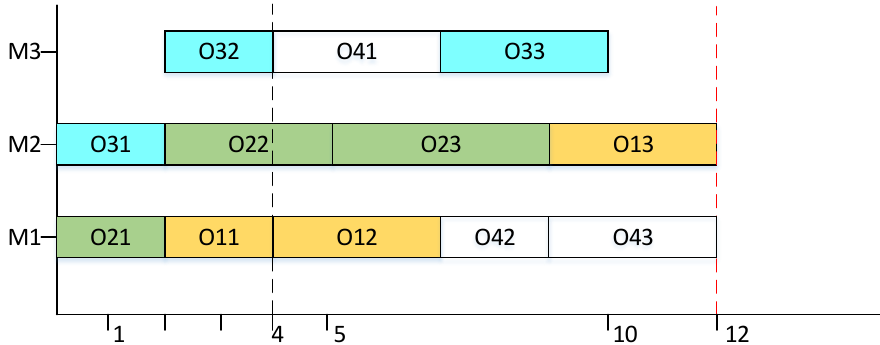
Figure 4. Scheduling scheme of method III with new job 4 insertion.